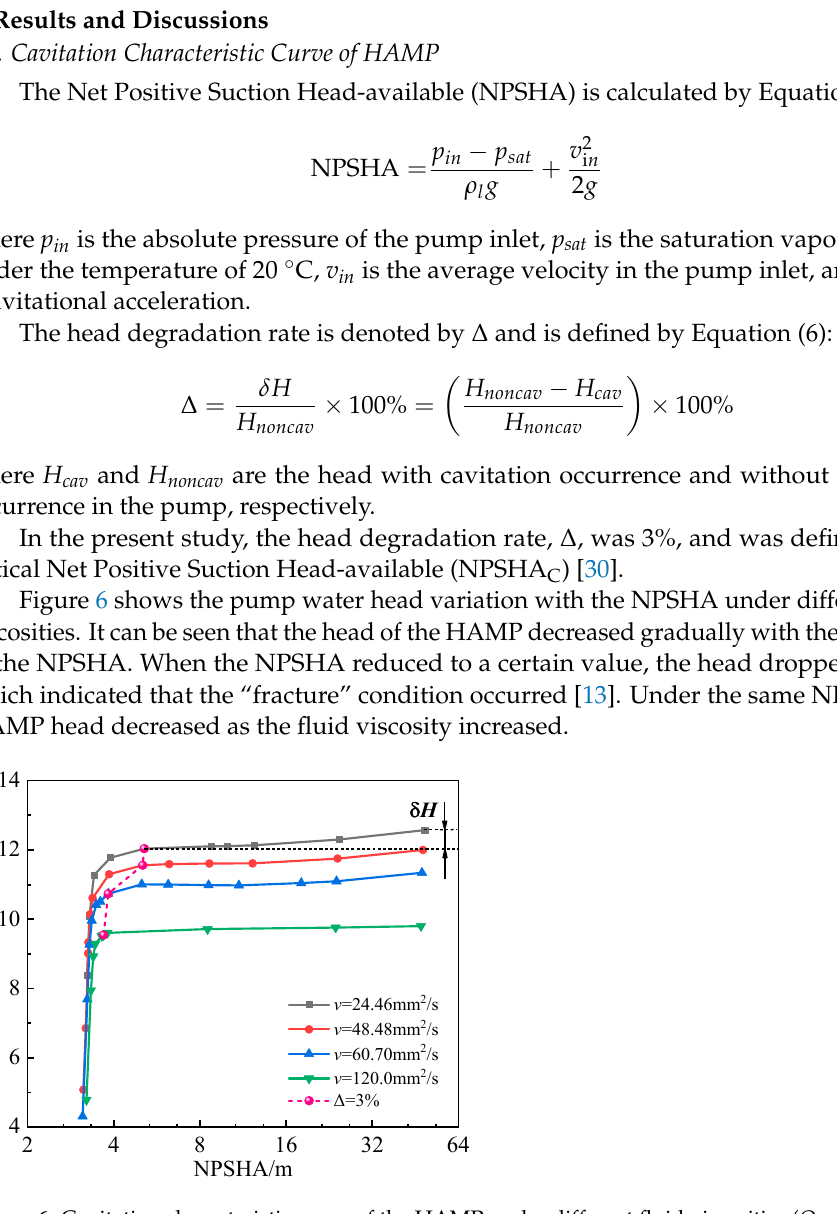
Figure 5. Water head comparison between simulation and experiment.